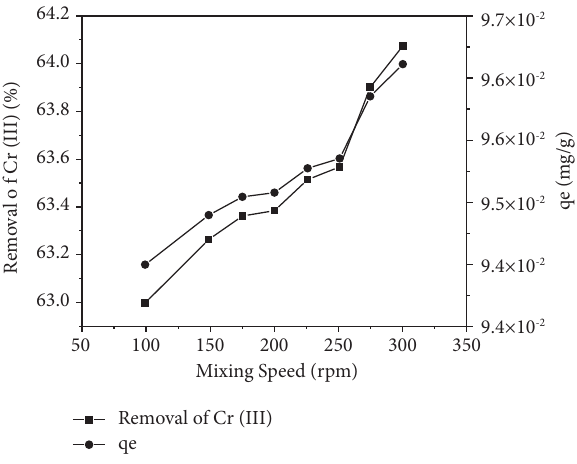
Figure 6: Efect of mixing speed on Cr (III)